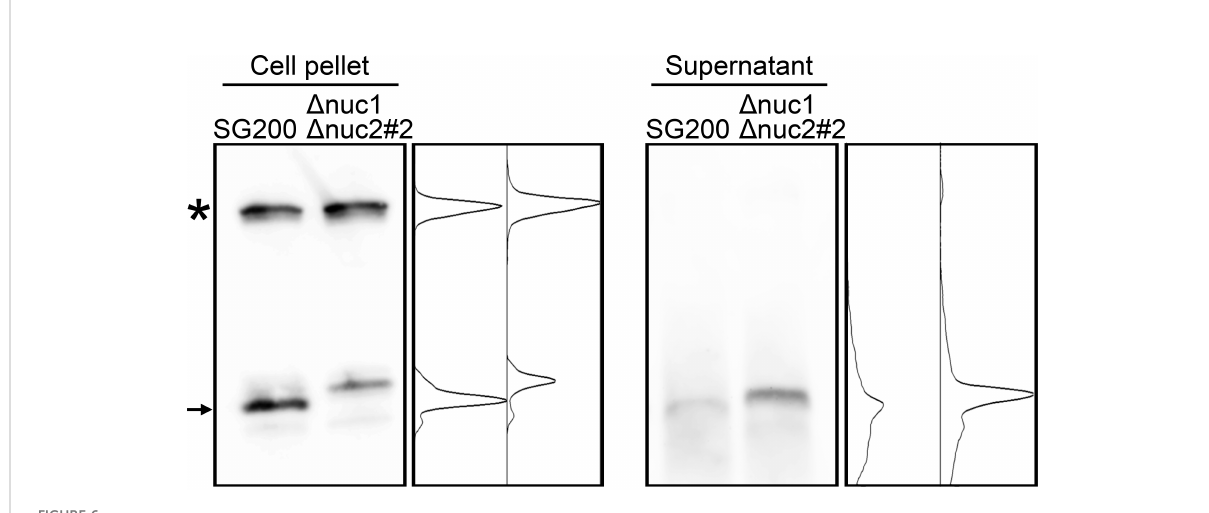
FIGURE 6 Northern blot analysis for the detection of tRNA-Gly fragment in culture supernatant of SG200 and SG200 D nuc1 D nuc2 mutant. Asterisk indicates the full-length tRNA-Gly. Arrow indicates major 5 ’ -tRNA fragment generated from full-length tRNA-Gly. Densitometry of tRNA fragment signals was shown at the right of respective